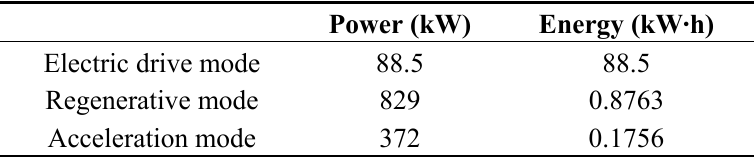
Table 2. Power and energy requirements for the